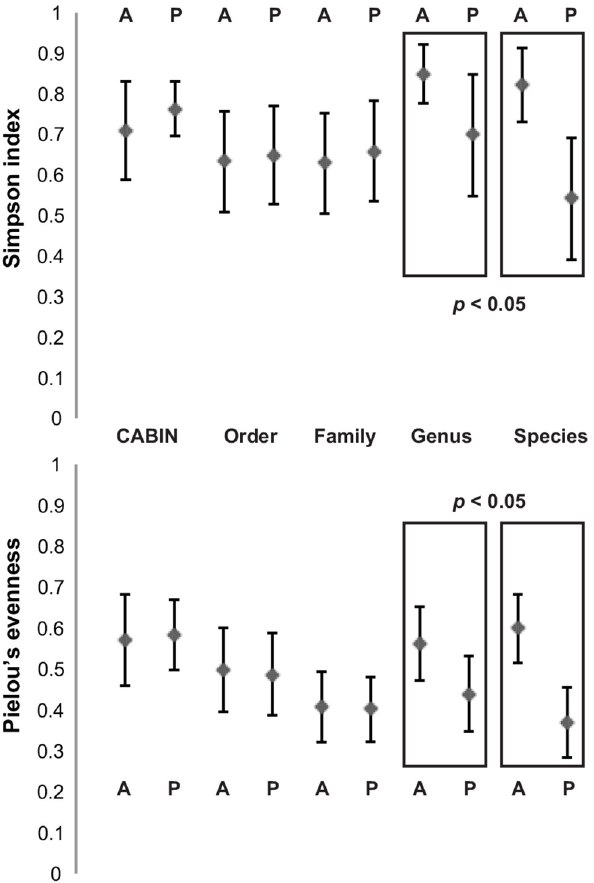
Fig 2. Alpha diversity metrics calculated for 24 benthic samples from the Peace-Athabasca delta at five different taxonomic levels via morphological identification and HTS. Means of all samples plus one standard deviation are depicted. Taxonomic levels at which a significant difference ( p < 0.05) between means of values for Athabasca and Peace sites are highlighted. A — Athabasca River sites. P – Peace River